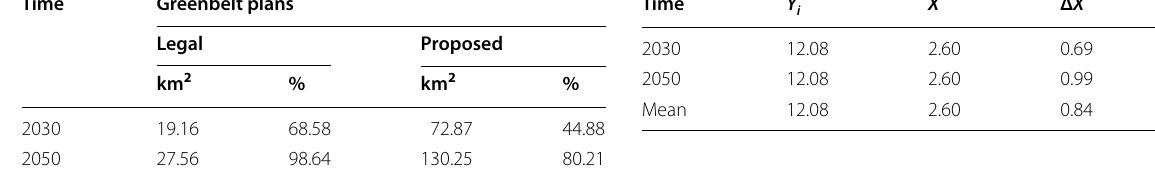
Table 5 Occupation rate of settlement extension inside of greenbelt plans based on two development probabilities in future Time Greenbelt plans